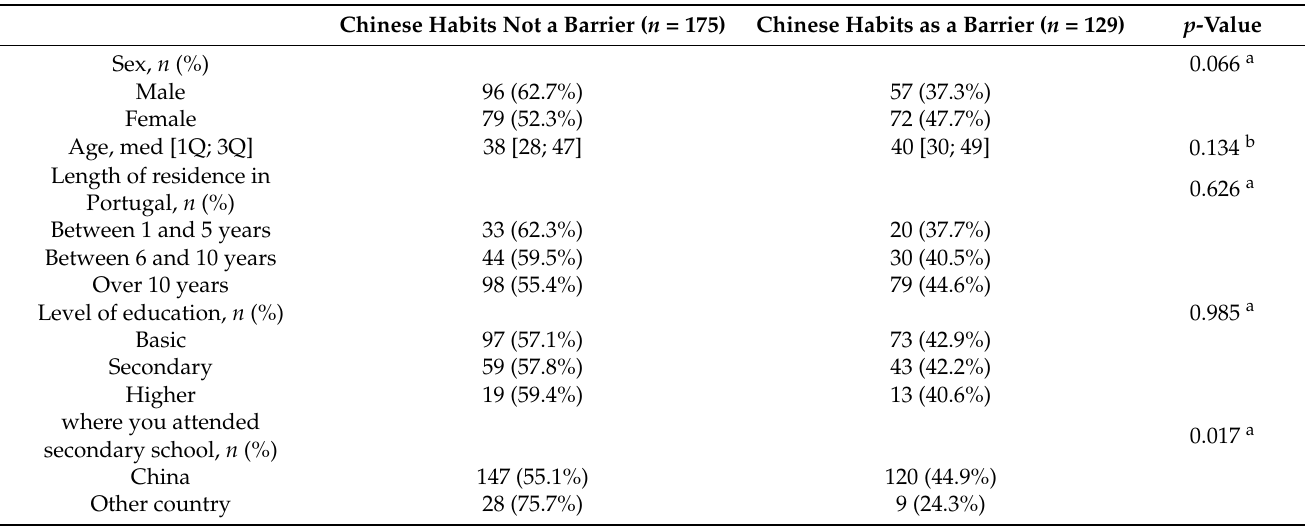
Table 4. Comparison of the variables sex, age, length of residence in Portugal, level of education and where you attended secondary school according to the indication of lack of knowledge of